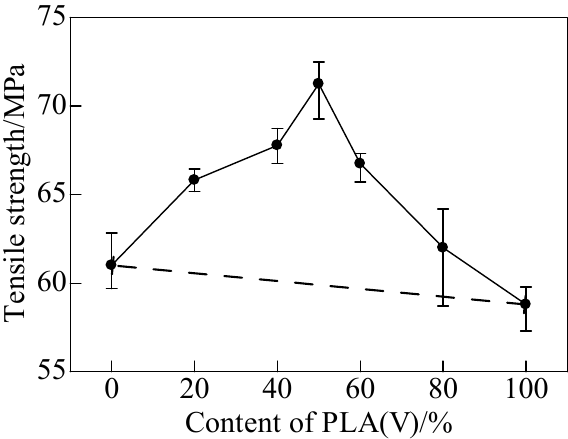
Figure 19. Tensile strengths of matrices and PLA/PMMA blends. Adapted from Reference [148].